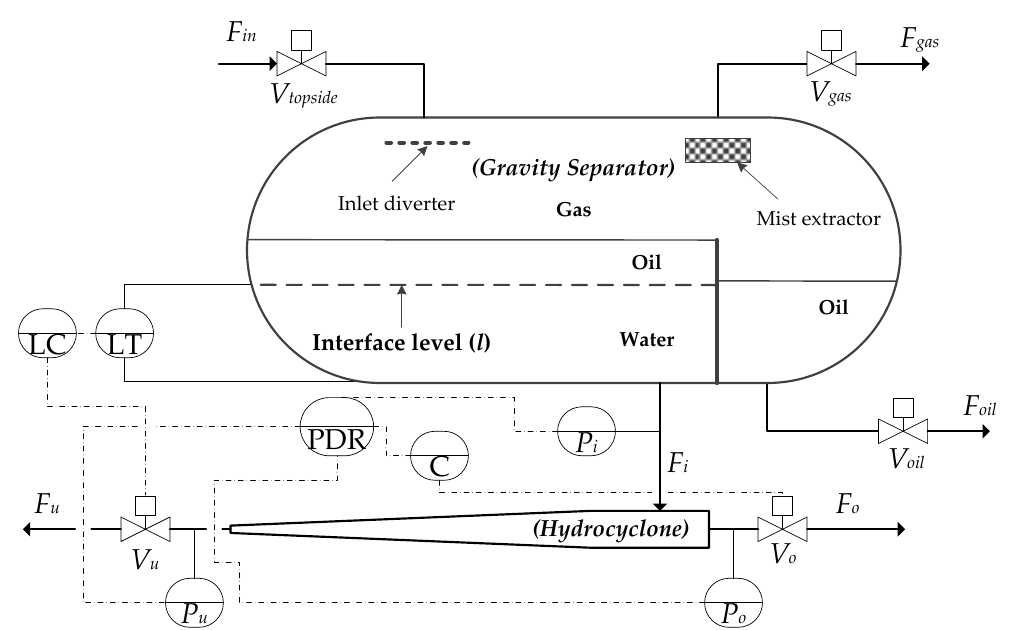
Figure 1. Schematic Piping and Instrumentation Diagram (P&ID) of an offshore de-oiling facility, including the control loops.